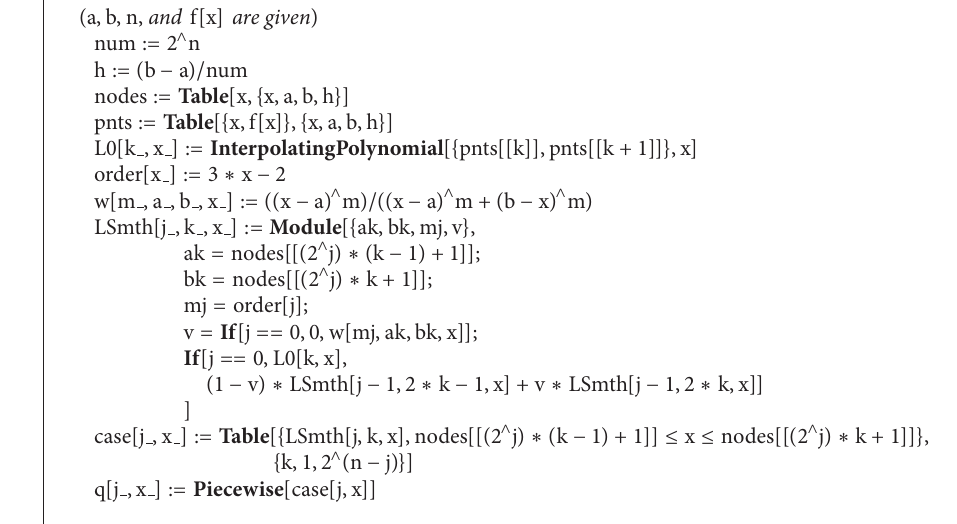
pnts := Table [{ x , f [ x ]},{ x , a , b , h }]